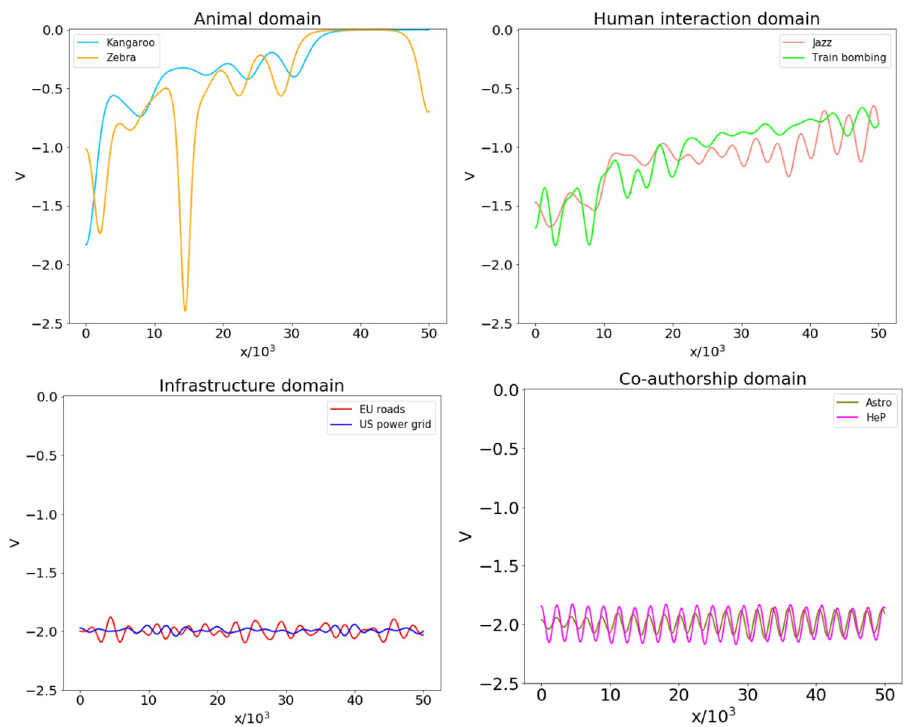
Fig 11. Real-world network potentials. Potentials reconstructed from the graph spectra of the real-world networks reported in Table 1, paired according to their domain.